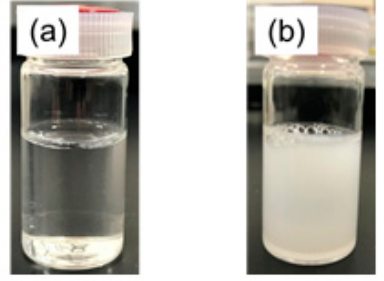
◦ C: ( a ) X M = 0; ( b ) X M =